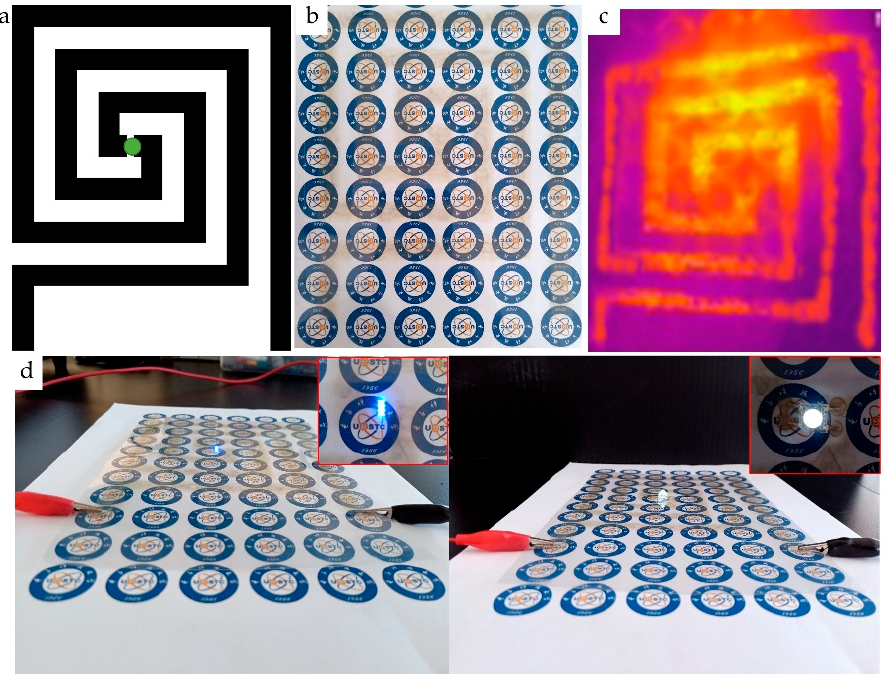
good conductivity.